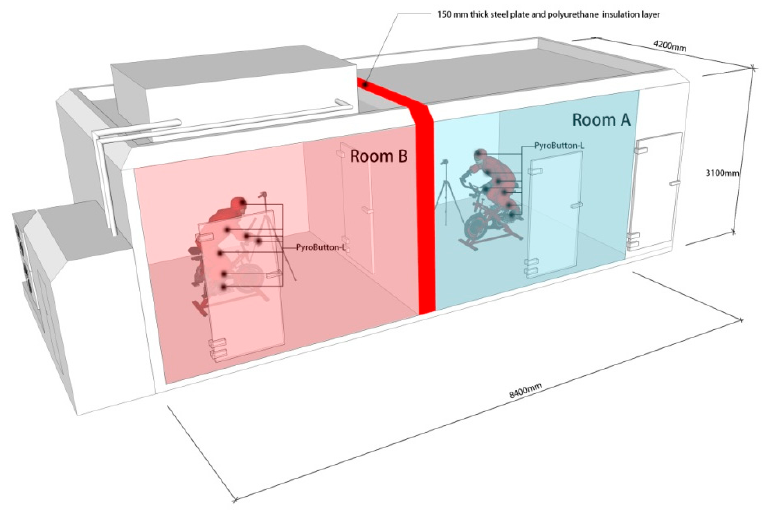
Figure 1. A schematic representation of the climate chamber.